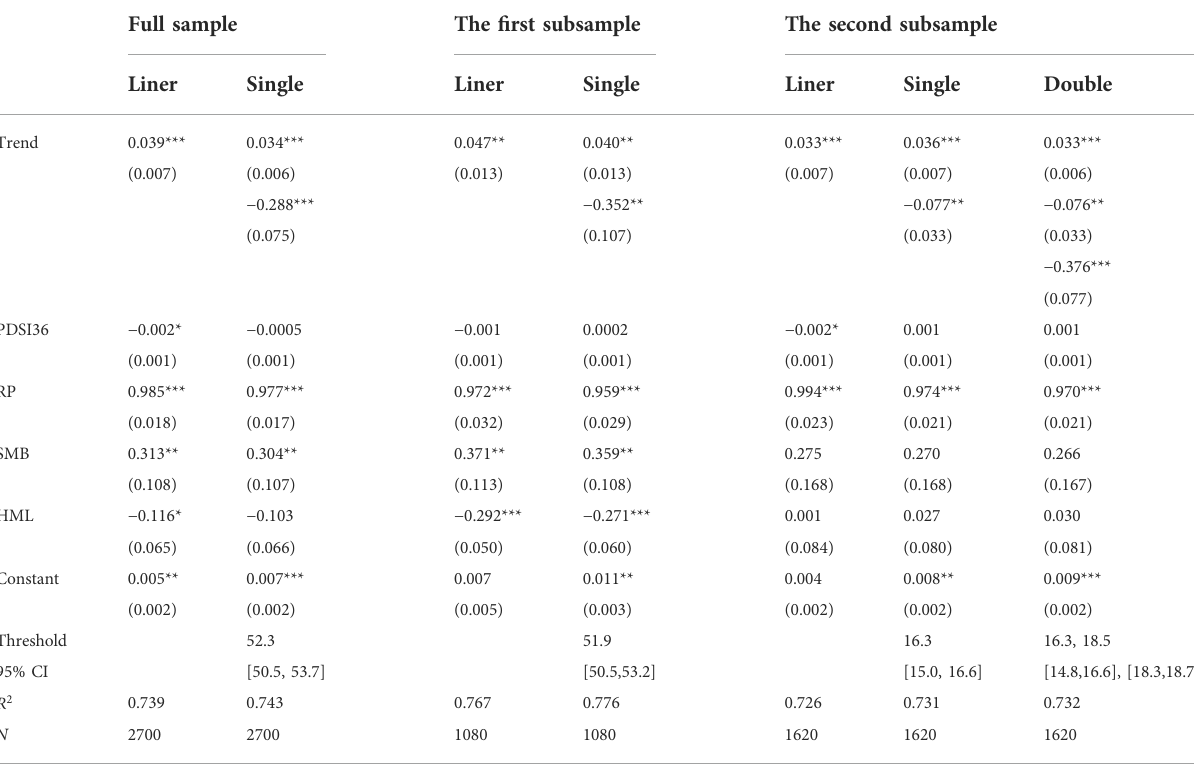
TABLE 9 Robustness check Ⅰ : Threshold regression results of investor sentiment considering quarterly precipitation